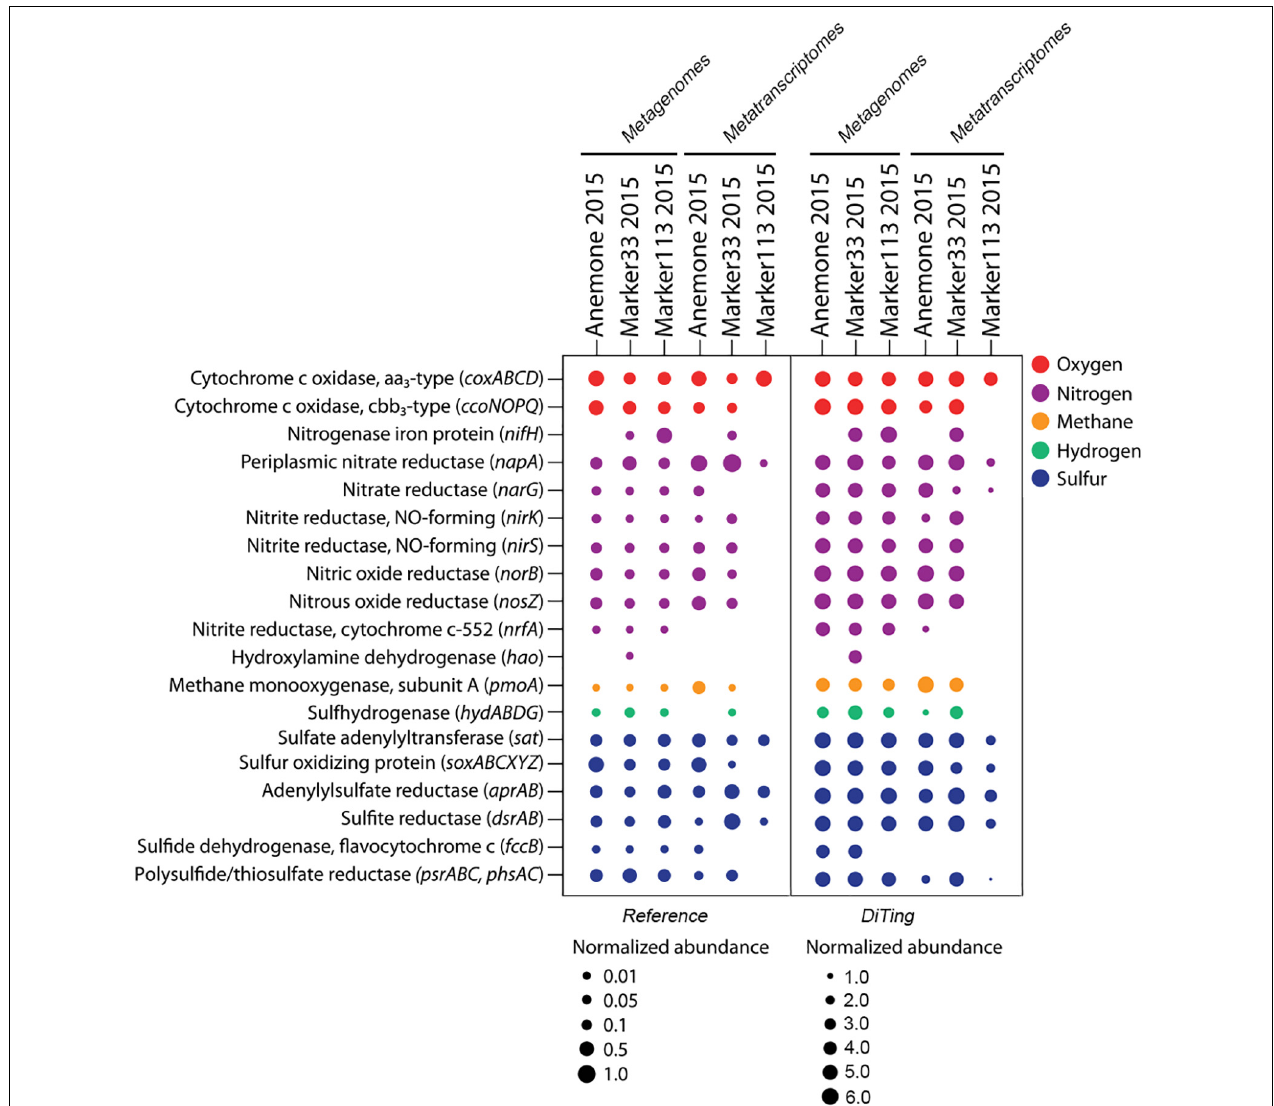
FIGURE 5 | Comparative analysis of the combination of metagenomic and metatranscriptomic datasets between a reference study and DiTing. The left panel is taken from reference (Fortunato et al., 2018), and shows normalized abundance and transcription of key genes for oxygen, nitrogen, methane, hydrogen and sulfur metabolism in hydrothermal vent metagenomes and metatranscriptomes. The right panel shows the results produced using analysis by DiTing. The normalized method is different from the reference. Multiply the relative abundance by 10 3 and transformed by